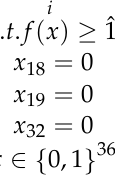
Figure 3. Convergence performance in case without considering equality constraints ( α = 5).